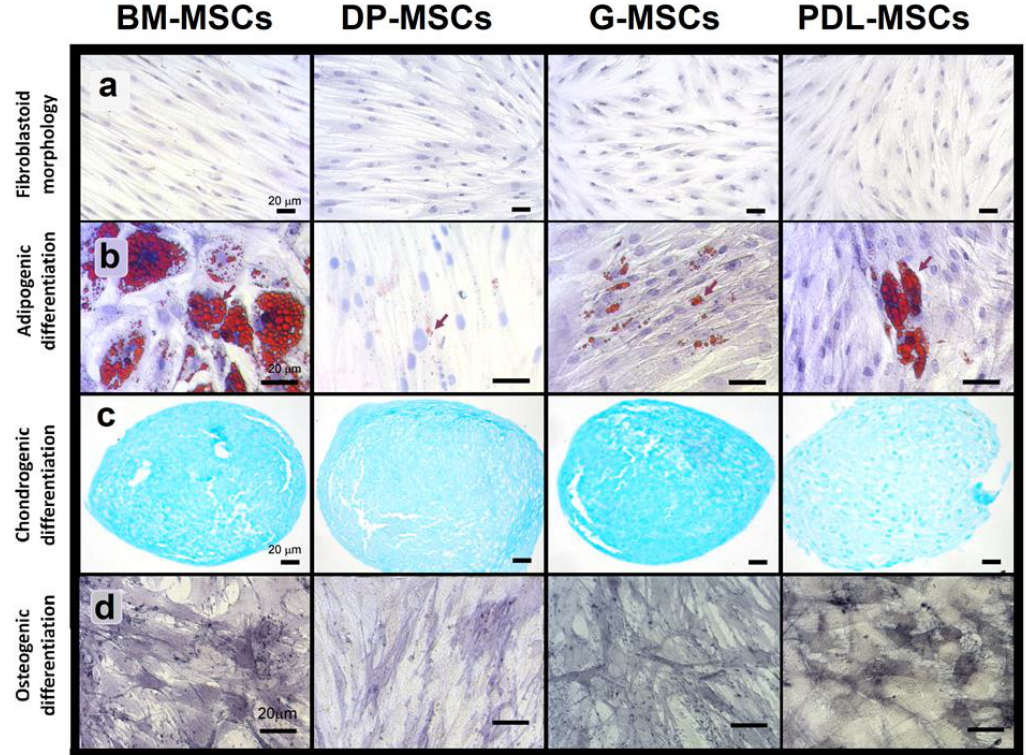
Figure 2. Morphology and differentiation capacity of mesenchymal stromal cells (MSCs) from bone marrow (BM), dental pulp (DP), gingival tissue (G), and periodontal ligament (PDL). Appearance of adherent cells with fibroblastoid morphology observed in cultures from the indicated sources (toluidine blue staining; magnification: 20×) ( a ). MSCs from the four cell sources (BM, n = 5; DP, n = 5; G, n = 5; and PDL, n = 5) were cultured in adipogenic, chondrogenic and osteogenic induction media for 35, 28, and 21 days, respectively ( b – d ). Adipogenic differentiation was indicated by the accumulation of neutral lipid vacuoles (Oil Red O; magnification: 40×) ( b ). Chondrogenic differentiation was indicated by chondrogenic matrix stained with alcian blue (cryosections from pelleted micromass; magnification: 20X) ( c ). Osteogenic differentiation was indicated by positive alkaline phosphatase enzyme staining (magnification: 40×) ( d ). One representative experiment is shown.